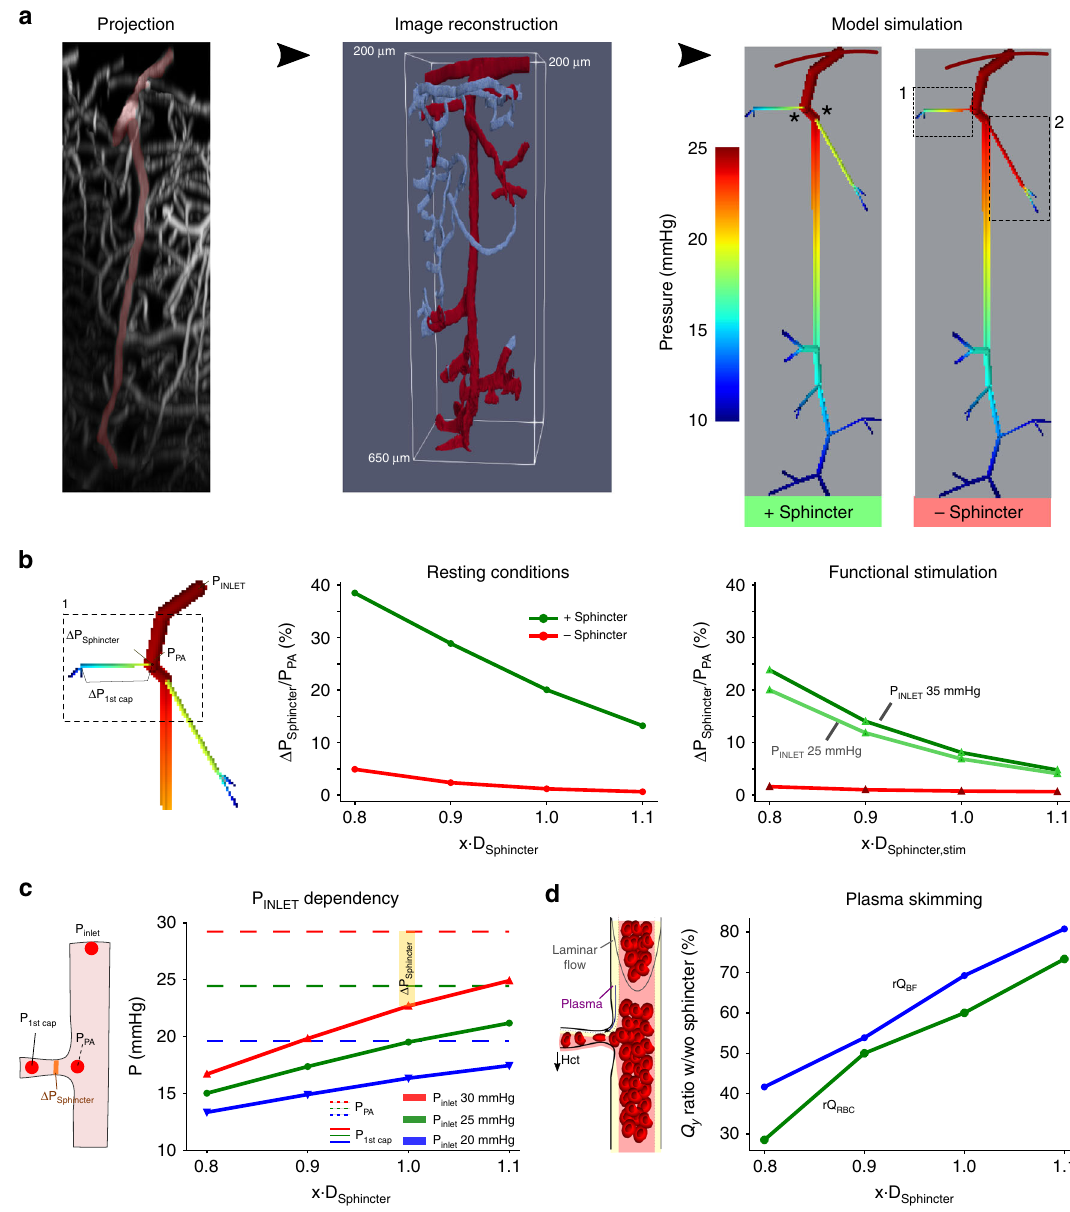
Fig. 7 Sphincters reduce pressure, fl ow, and hematocrit into capillaries. a An xz-projection of a z-stack covering an entire PA (left) was reconstructed (middle) and converted into a computational model of a PA and associated fi rst and second order capillaries. Model simulation (right) including the sphincters (green, marked by asterisks), or without the sphincters (red), observed in the two proximal branches along the PA gave rise to higly divergent pressure pro fi les along the fi rst order capillaries (highlighted boxes in the model without sphincters). b Pressure drop across the sphincter depends on its diameter. Focusing on the fi rst sphincter (left panel), the pressure drop across the sphincter ( Δ P Sphincter ) relative to the pressure at the branch point ( P PA ) was calculated as a function of sphincter diameters ( x ∙ D Sphincter ) under resting conditions (middle) or upon functional stimulation (right, using the relative changes in dilation from Fig. 3) with the sphincter (green curves) or without (red curves, where diameter of the sphincter is equal to the fi rst order capillary). c The degree of sphincter contraction correlates to the pressure in the PA. With increasing inlet pressures into the PA (20 mmHg: blue, 25 mmHg: green, and 30 mmHg: red), the PA pressure increases (dashed curves) and the sphincter must contract to maintain a relatively low pressure into the fi rst order capillary (full curves). The difference between the pressures in the PA and the fi rst order capillary is the pressure drop across the sphincter ( Δ P Sphincter , see inset). d Flow reduction and phase separation effects due to the sphincter. The ratios of blood fl ow ( rQ BF , blue curve) and RBC fl ow ( rQ RBC , green curve) with and without the sphincter ( rQ with_Sphincter / rQ without_Sphincter ) was calculated as a function of sphincter diameter. Both fl ows correlate proportionally with diameter but the RBC fl ow remains lower due to plasma skimming. Source data are provided as a Source Data fi